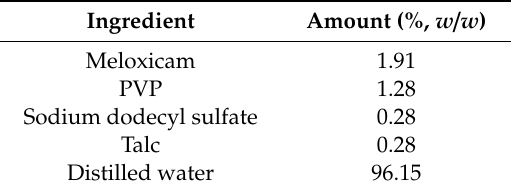
Table 2. Composition of the meloxicam dispersion used for drug layering.